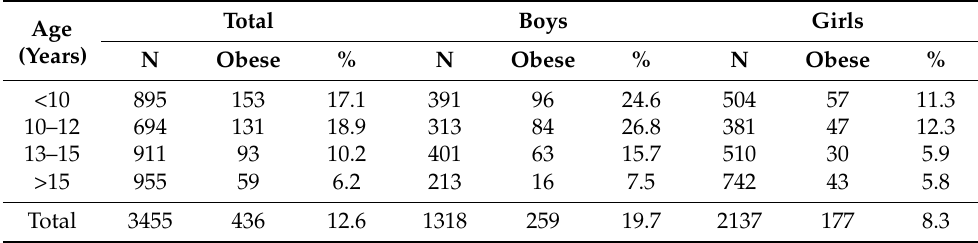
Table 1. Prevalence of obesity in study children by sex and age